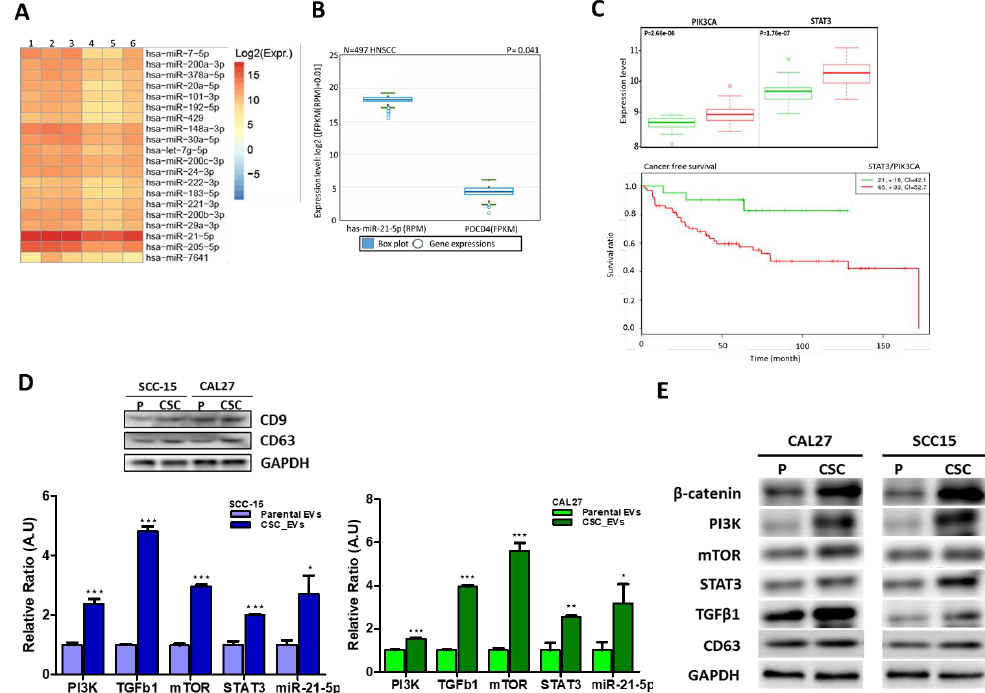
Figure 2. Cancer stem cells (CSCs) secrete extracellular vesicles (CSC_EVs) with oncogenic potential. ( A ) miR-21 is abundantly contained within EVs collected from six clinical oral squamous cell carcinoma (OSCC) samples [13]. ( B ) TCGA database analysis showed a strong reverse association between miR-21 and its target, the PDCD4 tumor suppressor. ( C ) Analysis of the GSE26549 database showed that increased PIK3CA and signal transducer and activator of transcription 3 (STAT3) mRNA levels log-rank equal curves p = 0.00148). A comparative qPCR analysis ( D ) and Western blots ( E ) between di ff erentiation 9 (CD9) and CD63 (markers of EVs) isolated from parental and tumor spheres (CSCs) of CAL27 and SCC-15 cells. CSC_EVs contained significantly higher levels of phosphatidylinositol-3 kinase (PI3K), transforming growth factor (TGF)- β 1, mammalian target of rapamycin (mTOR),